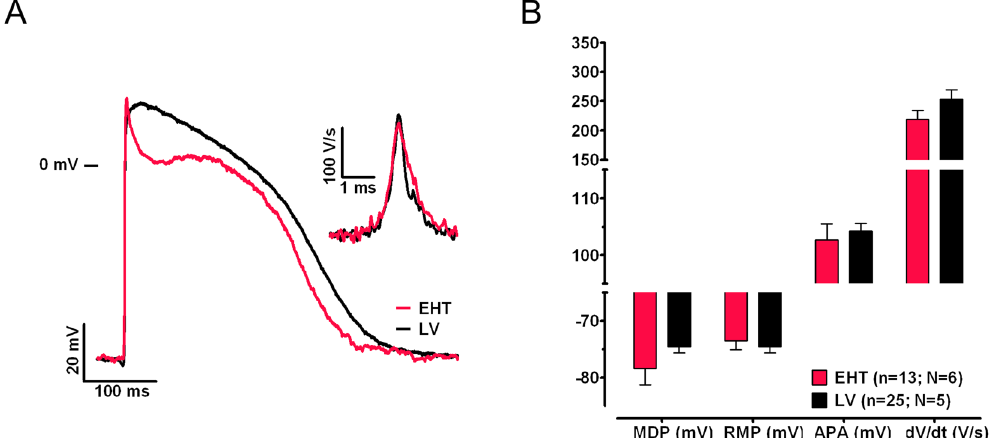
Figure 4. Action potential characterisation. ( A ) Example of action potentials (AP) and the AP upstroke velocity (inset) measured in human induced pluripotent stem cell-derived cardiomyocytes cultured in engineered heart tissue (EHT) or in human left ventricular tissue (LV) at 36.5 °C paced at 1 Hz. ( B ) Corresponding AP parameters. N: number of EHTs/LV tissues; n: number of impalements with the sharp microelectrode. RMP, resting membrane potential; APA, action potential amplitude; dV/dt, maximum upstroke velocity; APD 90 , AP duration at 90%